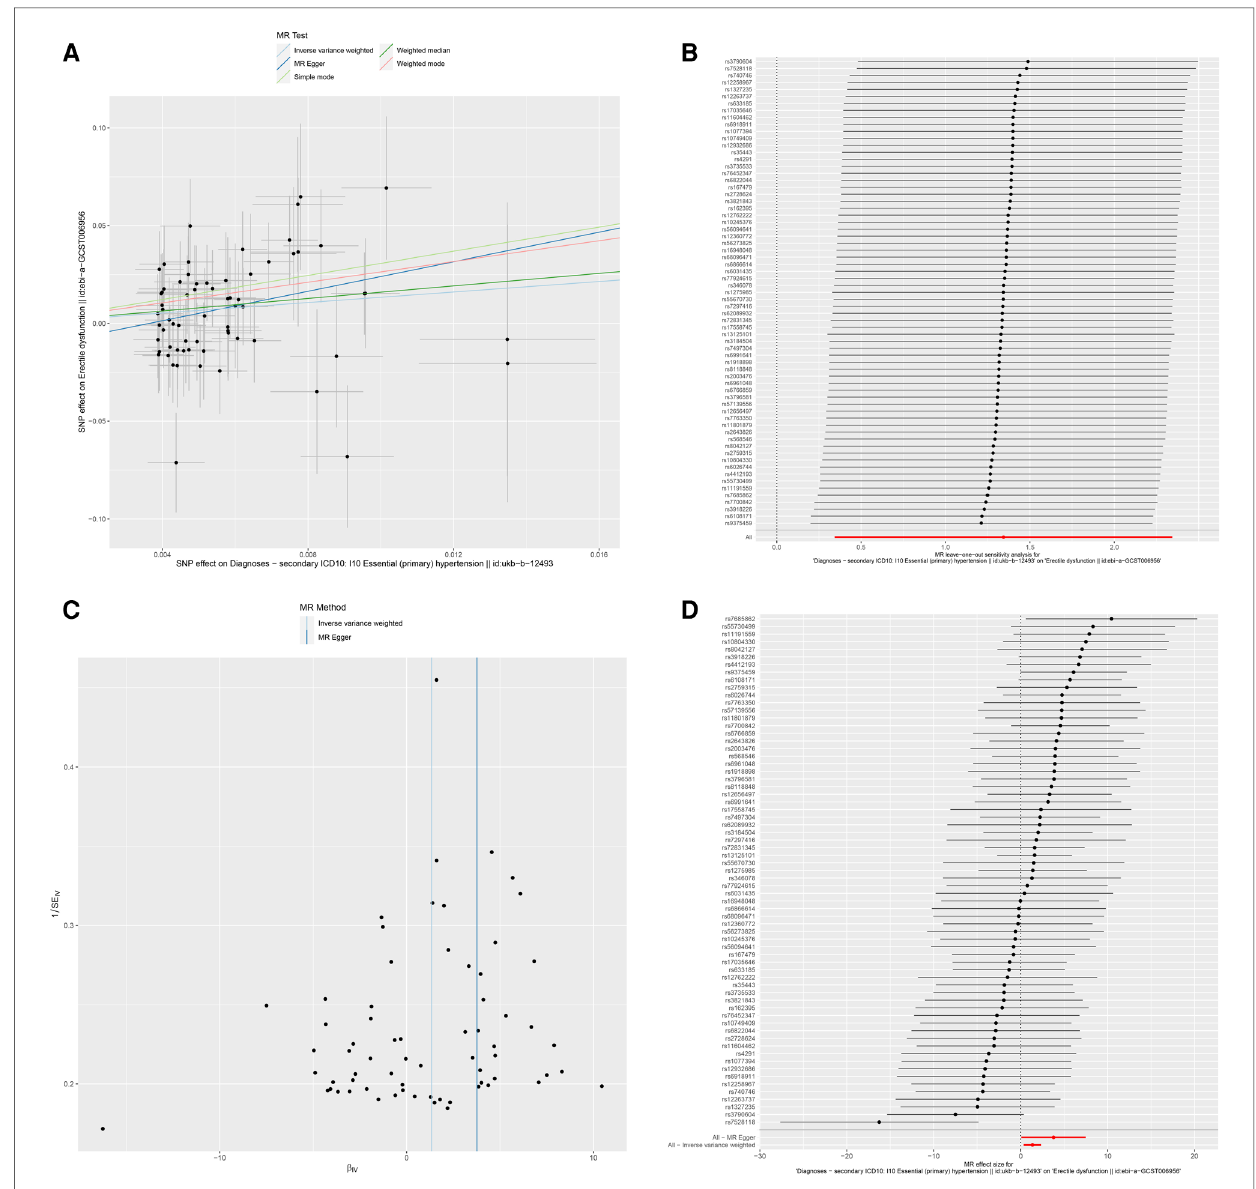
FIGURE 3 Association between hypertension and risk of erectile dysfunction. (A) multiple MR tests showed the SNP effects; (B) leave-one-out sensitivity analysis; (C) funnel plot for hypertension risk of ED; (D) effect size of each SNP. MR Mendelian Randomization, SNP single nucleotide polymorphism, ED erectile